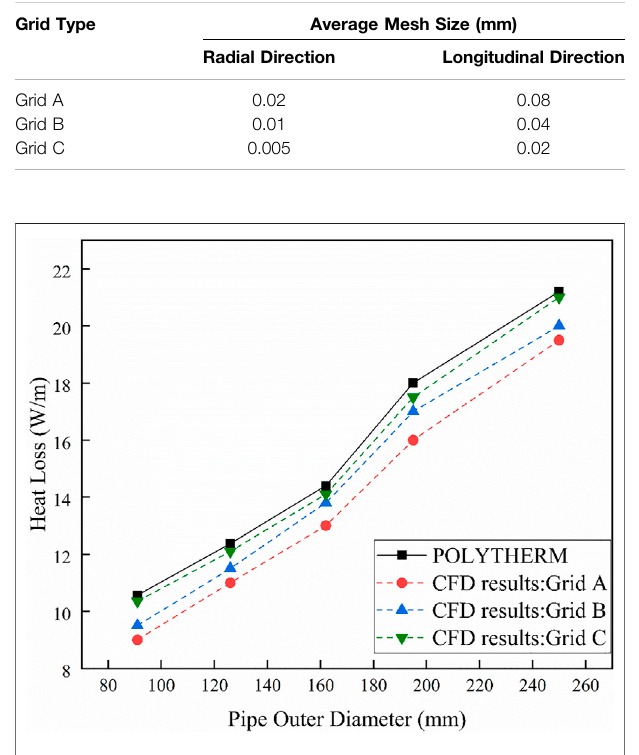
FIGURE 3 | The mesh grid sensitivity analysis and validation of the CFD results.